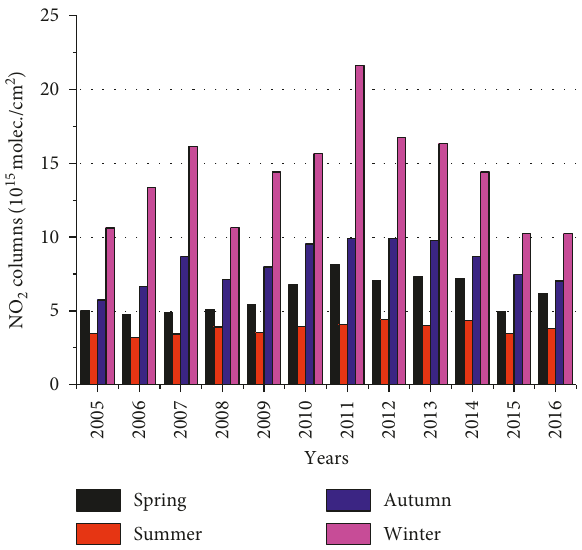
2 columns Figure 10: Average tropospheric NO 2 columns for four seasons from 2005 to 2016 in WCB.